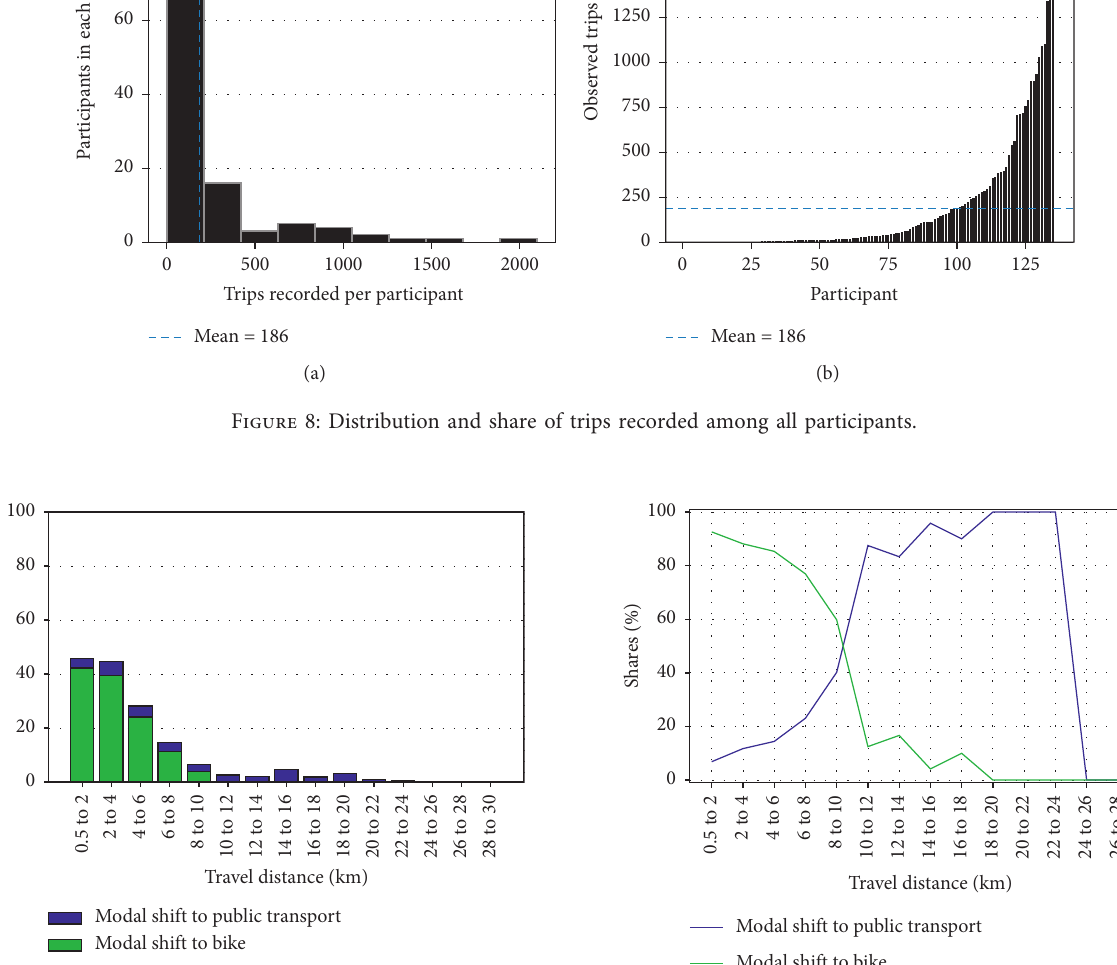
Figure 9: Observed car trips with a time-relevant low-carbon alternative, depending on travel distance.